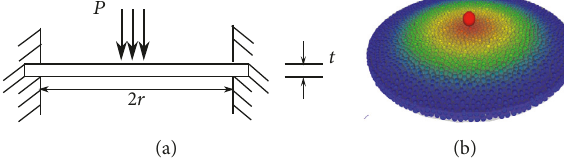
Figure 20: Circular plate clamped subjected to a central load (a) and the DEM model